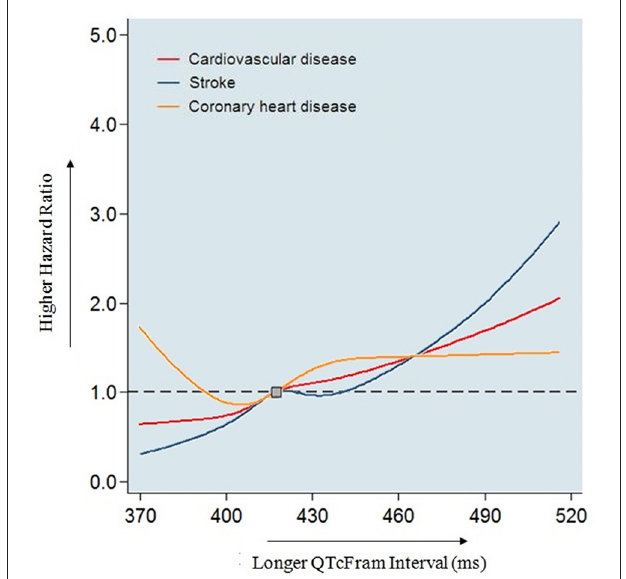
FIGURE 4 | Association of baseline QTc interval with coronary heart disease, stroke, and combined cardiovascular disease in 8,867 Chinese participants. Models adjusted for age, sex, ethnicity, current smoking, family history of coronary heart disease, body mass index, systolic blood pressure, antihypertensive medications, fasting plasma glucose, total cholesterol, triglyceride, high-density lipoprotein cholesterol, low-density lipoprotein cholesterol and estimated glomerular filtration rate, QT prolonging medications, statin use, warfarin use and aspirin use, atrial fibrillation and left ventricular hypertrophy. In this study, we found prolonged QTc interval was associated with incident stroke and combined cardiovascular disease, but not coronary heart disease in adults without prior cardiovascular disease in a general Chinese